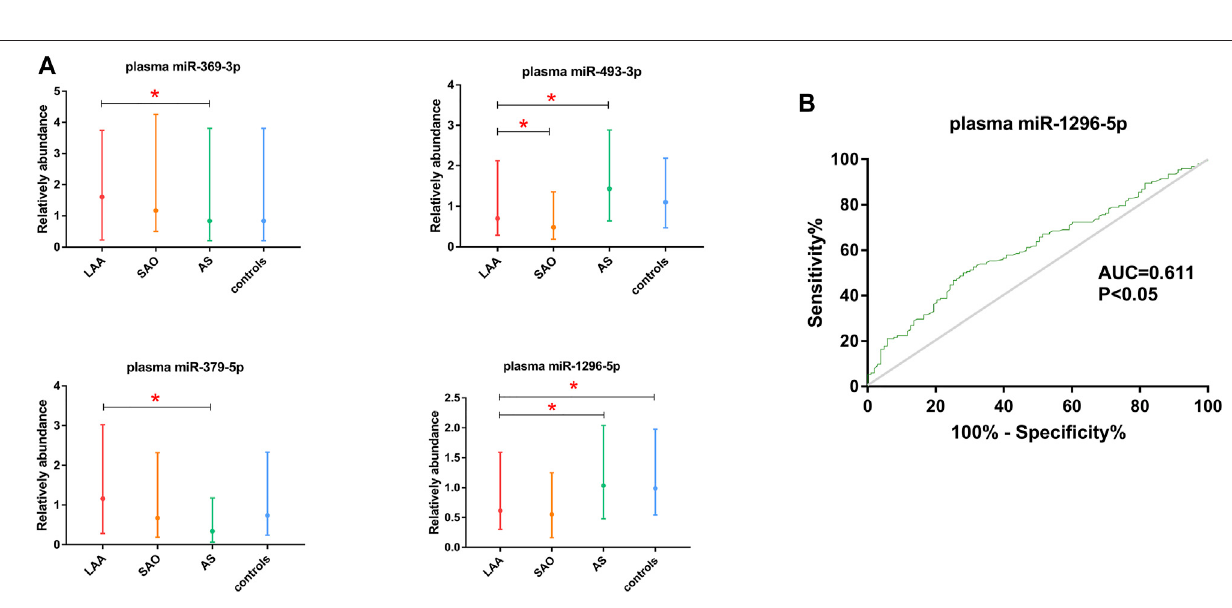
Frontiers in Pharmacology |